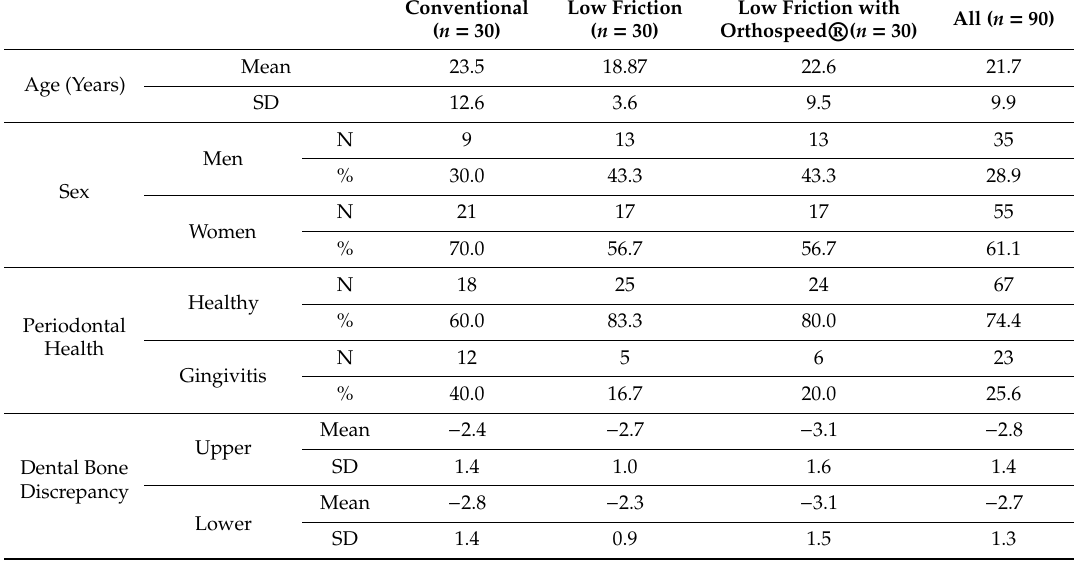
Table 4. Comparison of the impact on the dimensions of oral quality of life.